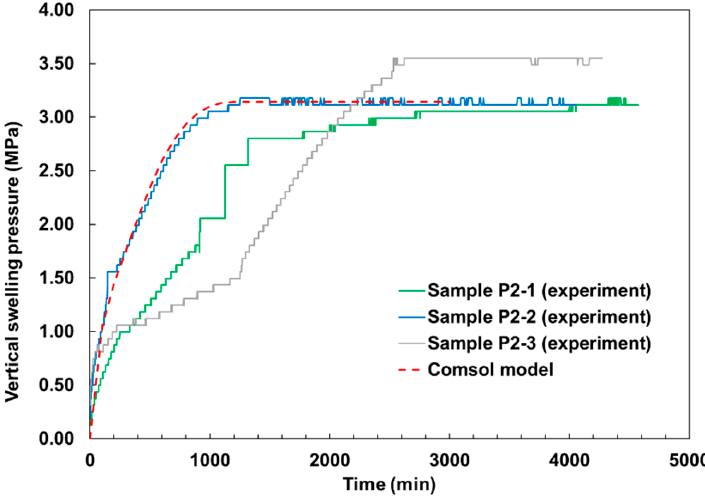
Figure 4. Swelling pressure evolution during hydration under confined volume conditions.